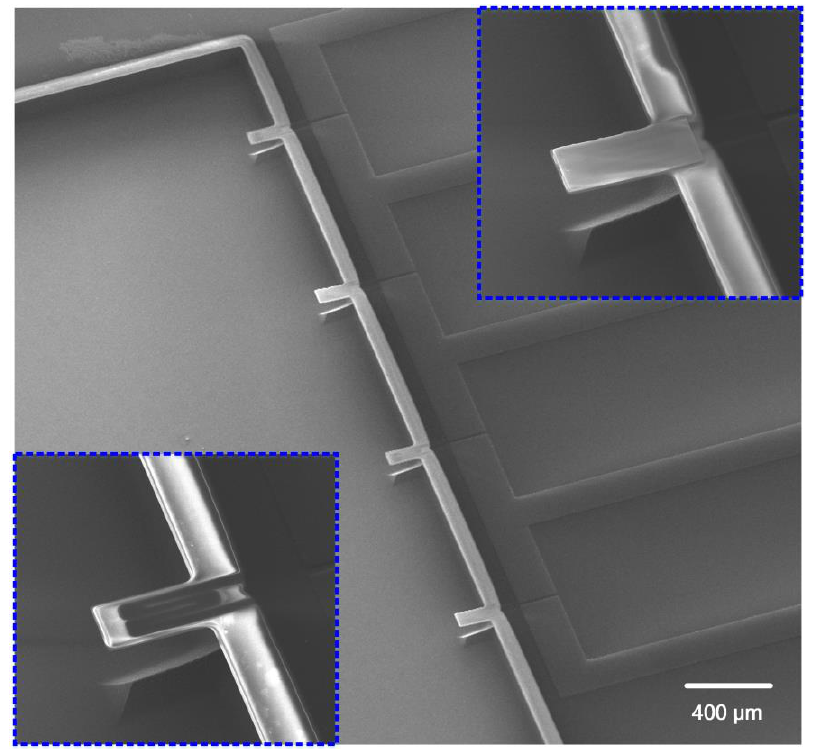
Figure 3. The SEM photo of fabricated polymeric micro-cantilever array (Top-right and left insets present a sensing cantilever and a reference cantilever, respectively).